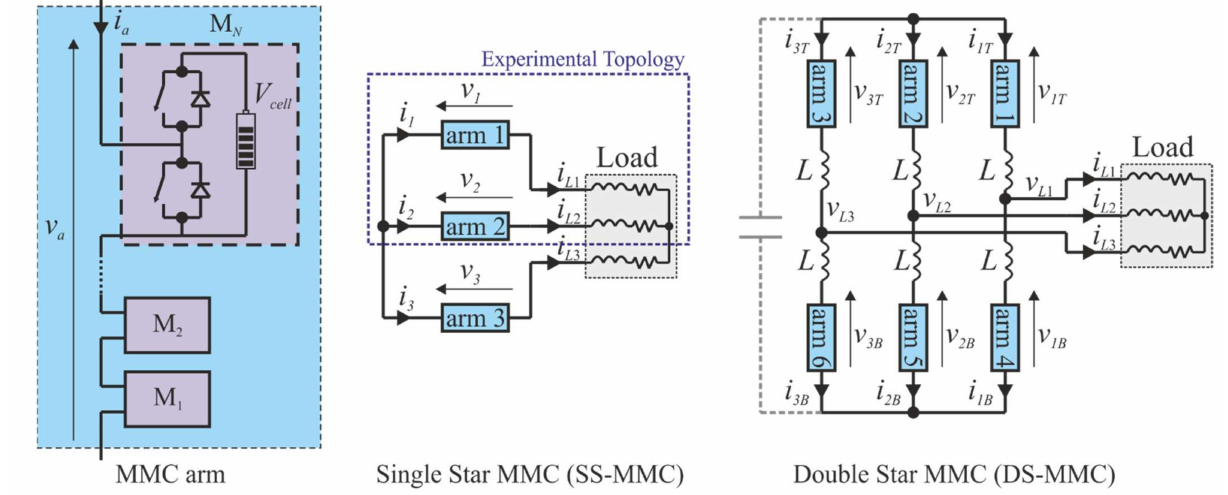
Figure 1. Modular Multilevel Converters